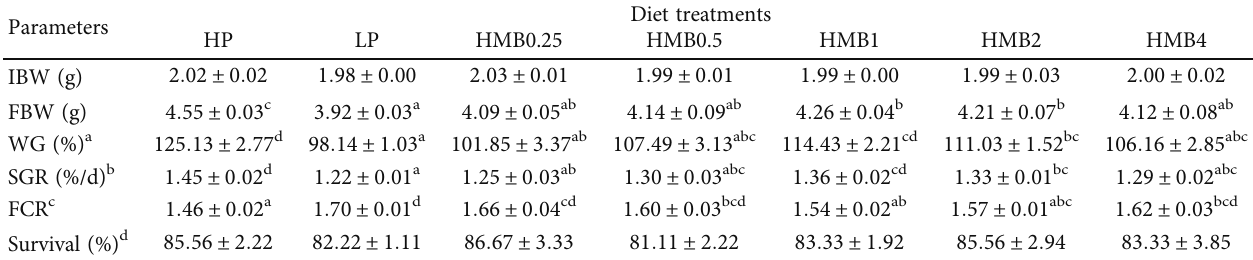
Table 4: Growth performance of kuruma shrimp fed with the experimental diets. Parameters